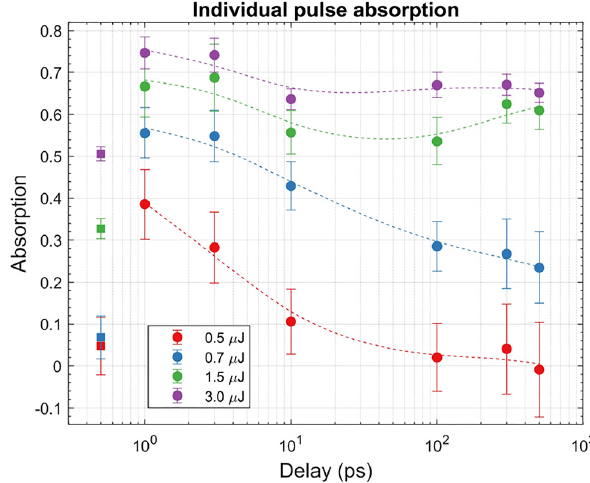
Figure 6: Second pulse absorption as a function of the inter-pulse delay, for different individual pulse energies. For reference, we indicate with square markers the absorption of the fi rst pulse. Dashed lines correspond to B-spline interpolation. The error bars correspond to one standard